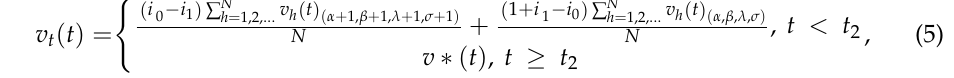
Figure 5. Membership function of αE v ( t ), βE vc ( t ), λ 1 Δ K p ( t ), and σ 1 Δ K i ( t ).